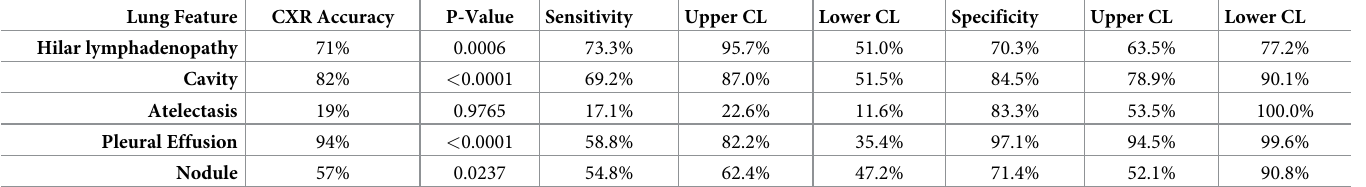
Table 7. 187 TBPP CXR Annotations for New TB Patient Case versus Qure.ai Binary Prediction, Crosstabulation Summary Statistics.